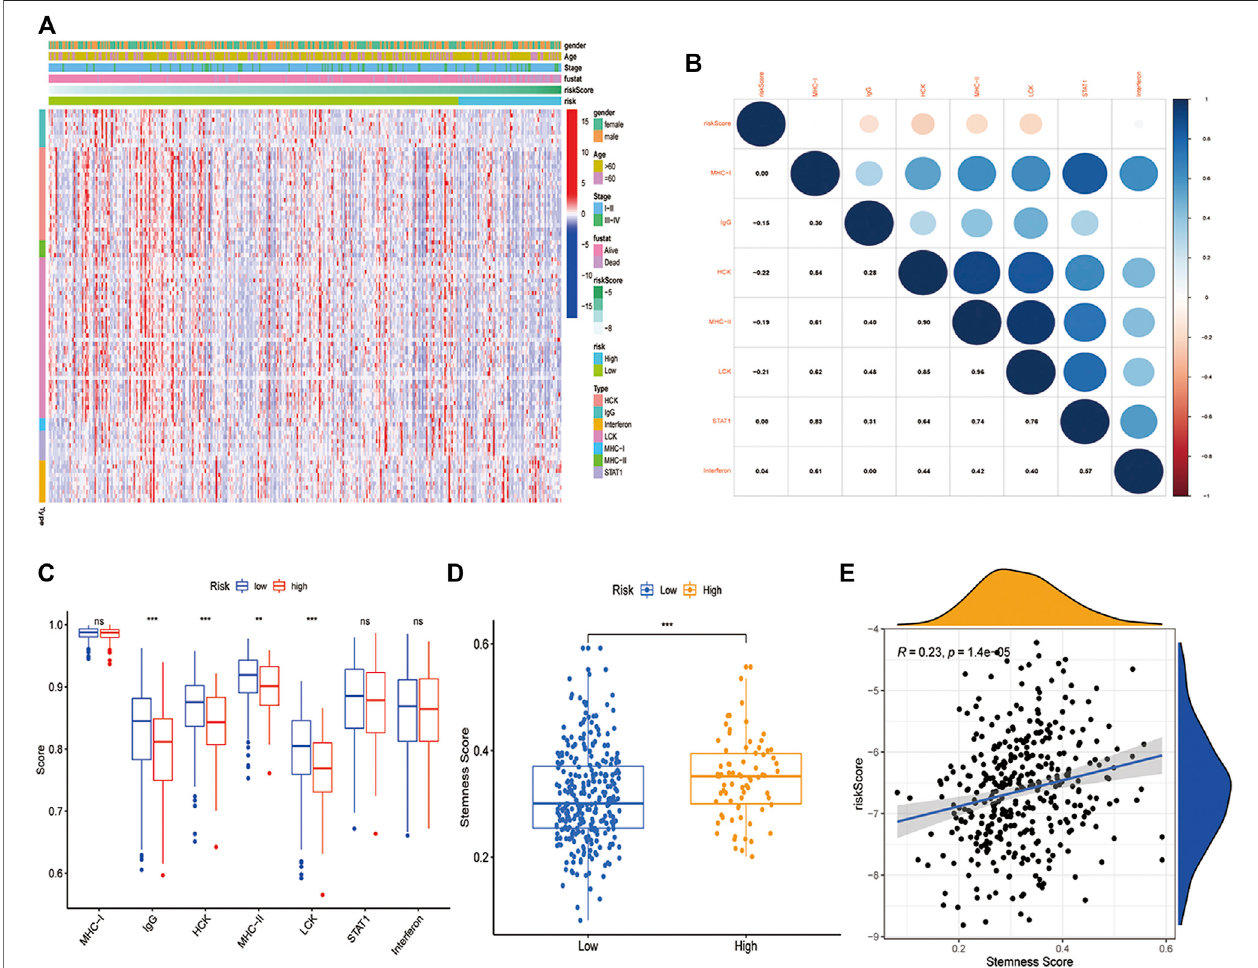
FIGURE 6 | In fl ammatory and immunologic pro fi le of the PCD-related signature in TCGA cohort. (A) Heatmap showed the gene expression of immune-in fl ammatory metagenes in the two risk groups (blue: low expression level; red: high expression level). (B) A correlogram was generated based on Pearson p -value between risk score and metagenes. (C) Comparisonoftheimmune-in fl ammatorymetagenesinhigh-riskandlow-riskgroups. (D) Comparisonofthestemnessscoreinhigh-riskandlow-riskgroups. (E) Correlation of stemness score and risk score (R = 0.23, p < 0.05). (*, **, ***, and **** represent p < 0.05, p < 0.01, p < 0.001 and p < 0.0001, respectively).